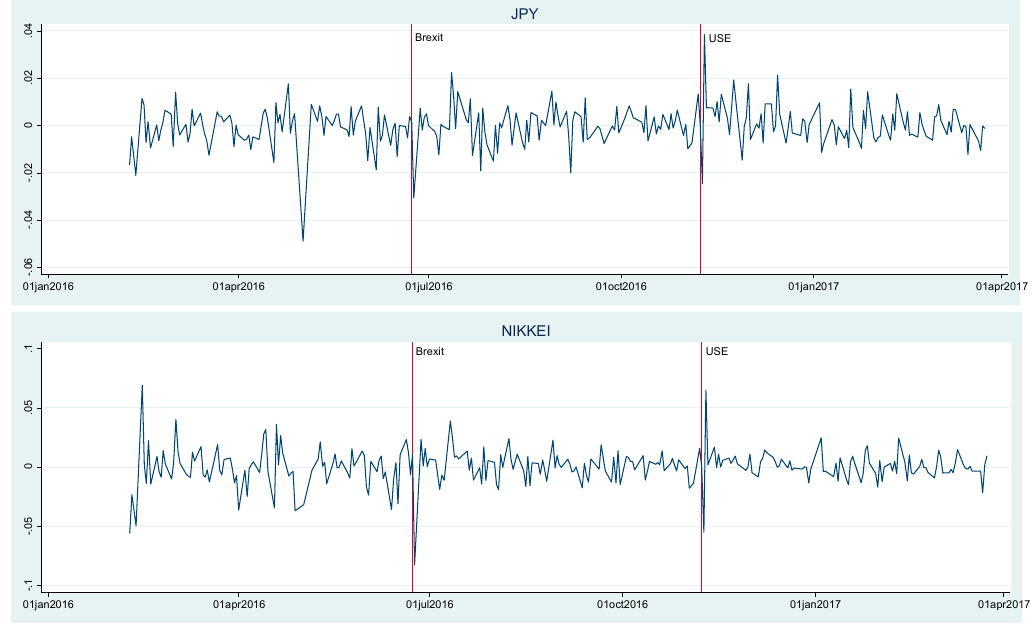
Figure 2. Logarithmic returns of the JPY daily exchange rate and the Nikkei closing price index.